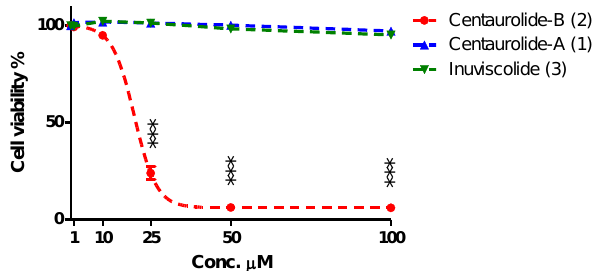
Figure 2. Effect of centaurolide-A ( 1 ), -B ( 2 ) and inuviscolide ( 3 ) on cell viability in human cervix adenocarcinoma cells (HeLa cells). Hela cells were treated with various concentrations (1, 10, 25, 50, 100 μM) of centaurolide -A ( 1 ), centaurolide-B ( 2 ), and inuviscolide ( 3 ), for 24 h and then cell viability was determined by SRB assay. Data has been plotted with non-linear regression. Different data points represent mean ± standard error (SE) of three independent experiments (n = 3); *** p < 0.001 compared to the corresponding vehicle. Statistical analysis was carried out using one-way ANOVA followed by Bonferroni as post hoc test.